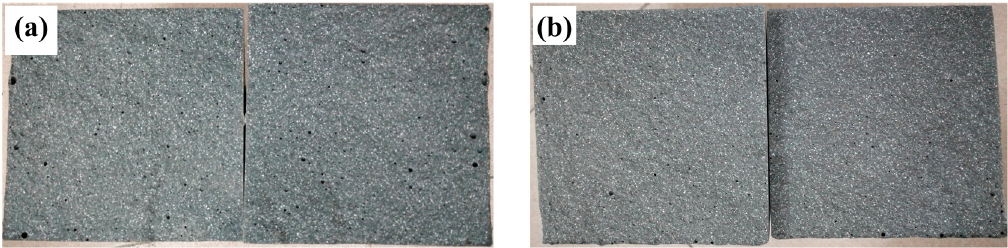
Figure 5. The pictures of the UHPC matrix section: ( a ) CGS-0.8-0.16; ( b ) CGS-0.8-0.17.